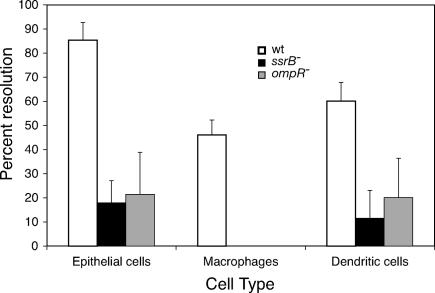
Expression from PsseA during Infection of Mammalian Cells In VitroThe human epithelial cell line HeLa, murine macrophage cell line RAW264.7, and bone-marrow-derived DCs were infected with wild-type (NB25), ssrB − (NB7), and ompR − (NB15) RIVET strains as described in Materials and Methods. At 1 h post-infection intracellular bacteria were recovered and the percent resolution was determined.